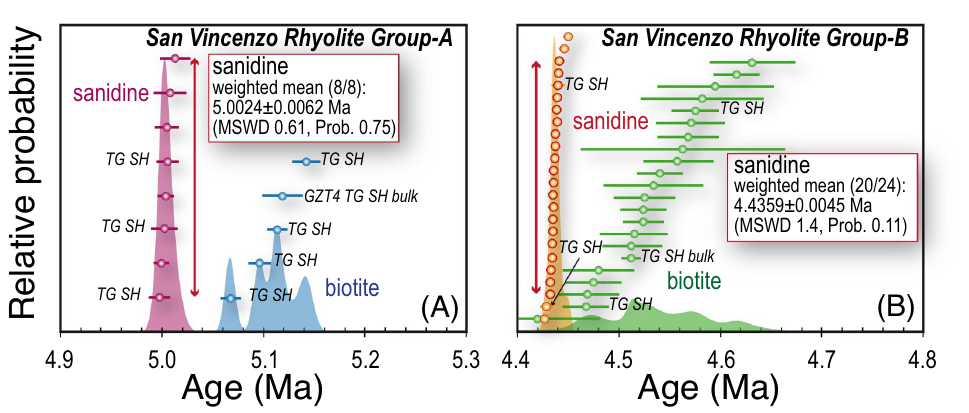
Figure 6. Cumulative probability and ranked distribution of 40 Ar– 39 Ar apparent ages of sanidine and biotite from Group-A ( A ) and Group-B ( B ) of the San Vincenzo Rhyolite. Data are total fusion ages obtained from total fusion analyses of individual grains or calculated as total gas ages from step-heating experiments on single grains of both sanidine and biotite (TG SH) or on multigrain aliquots of biotite (TG SH